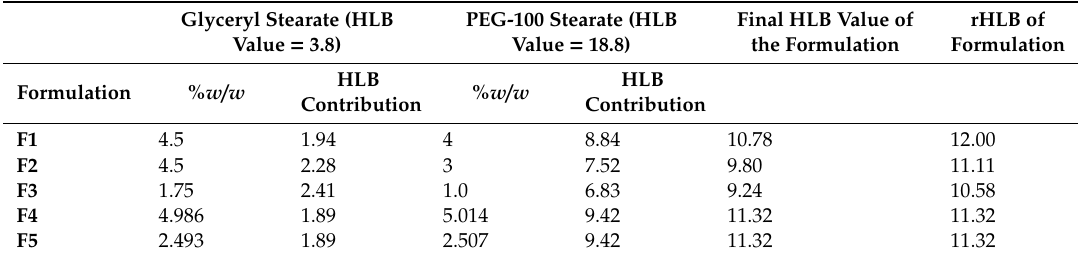
Table 3. The hydrophilic–lipophilic balance (HLB) contribution by individual emulsifiers of di ff erent formulations to achieve the required hydrophilic–lipophilic balance (rHLB). Glyceryl Stearate (HLB PEG-100 Stearate (HLB Final HLB Value of rHLB of Value = 3.8) Value = 18.8) the Formulation Formulation HLB HLB Formulation % w / w % w / w Contribution Contribution F1